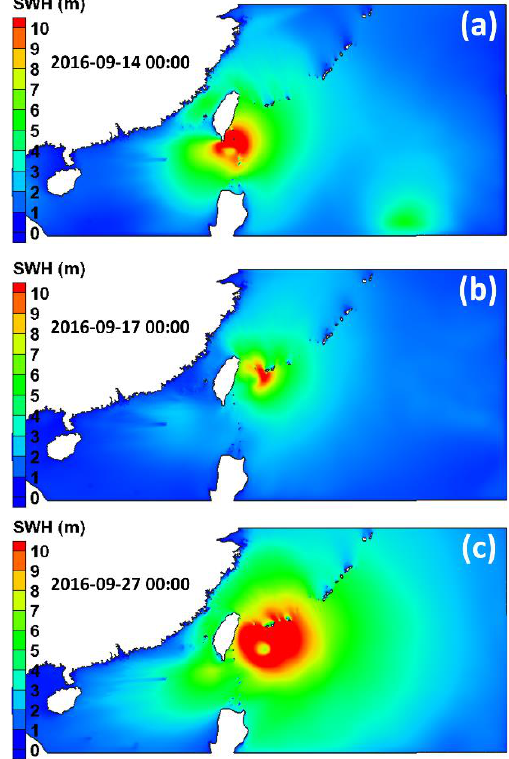
Figure 10. Spatial distribution of the simulated significant wave height at ( a ) 00:00 on 14 September 2016, ( b ) 00:00 on 17 September 2016, and ( c ) 00:00 on 27 September 2016, using the D03 computation domain and ERA5 wind fields.